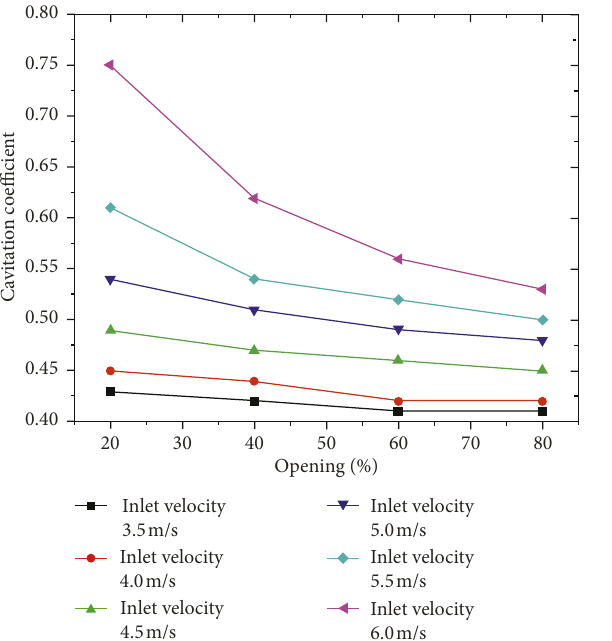
Figure 44: Nominal diameter constant opening and cavitation coefficient with inlet velocity.